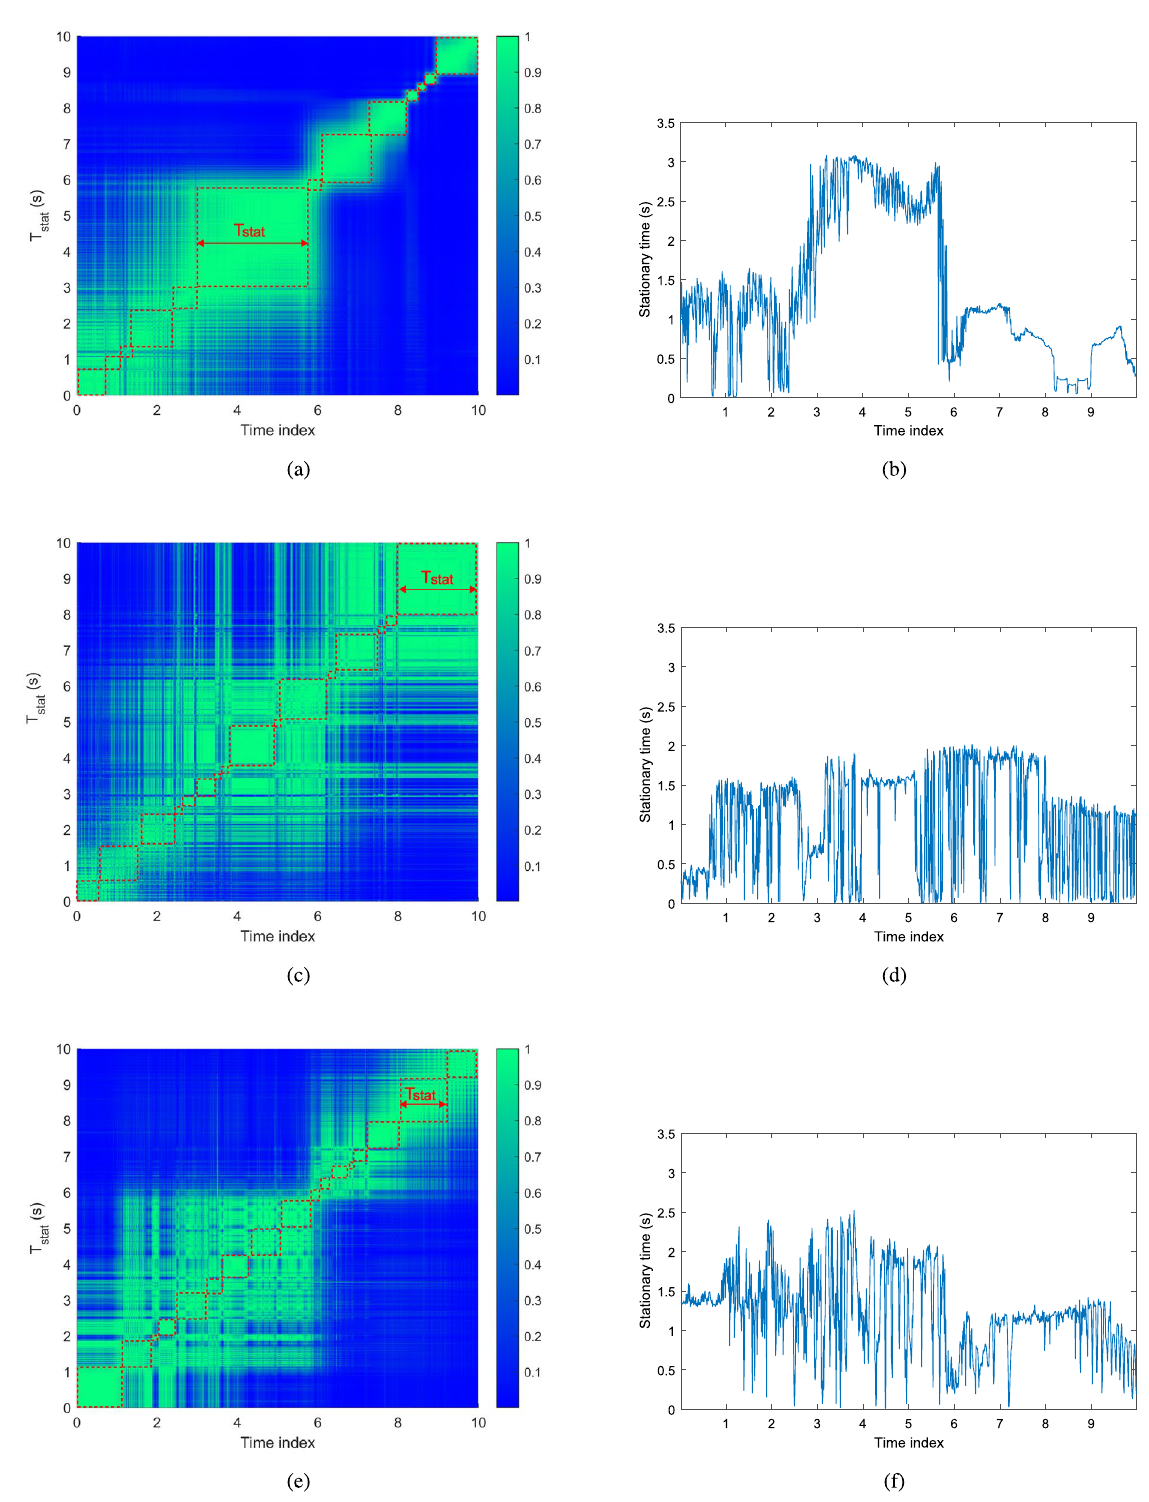
Figure 2. Collinearity in time and stationary time for the measurements. ( a , b ) Iron bridge. ( c , d ) Soundproof wall. ( e , f ) Roadside